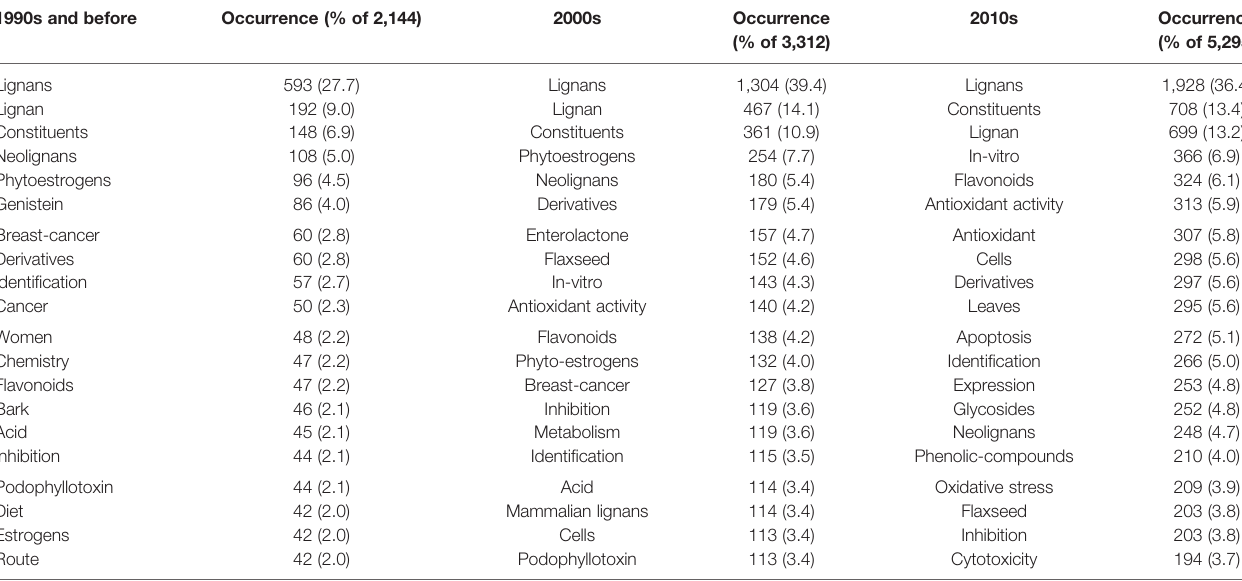
TABLE 5 | The top 20 recurring keywords in each decade. 1990s and